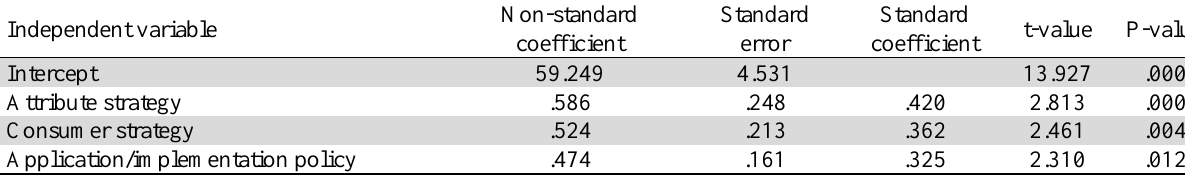
The summary of regression